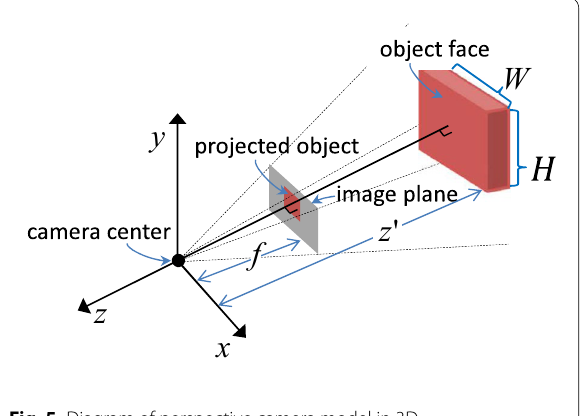
Fig. 5 Diagram of perspective camera model in